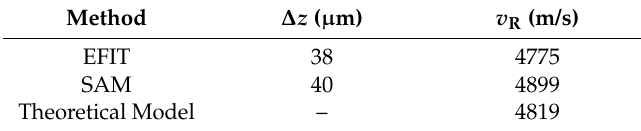
Table 2. Rayleigh wave velocity results at 400 MHz for 1 μ m aluminium coating on silicon.